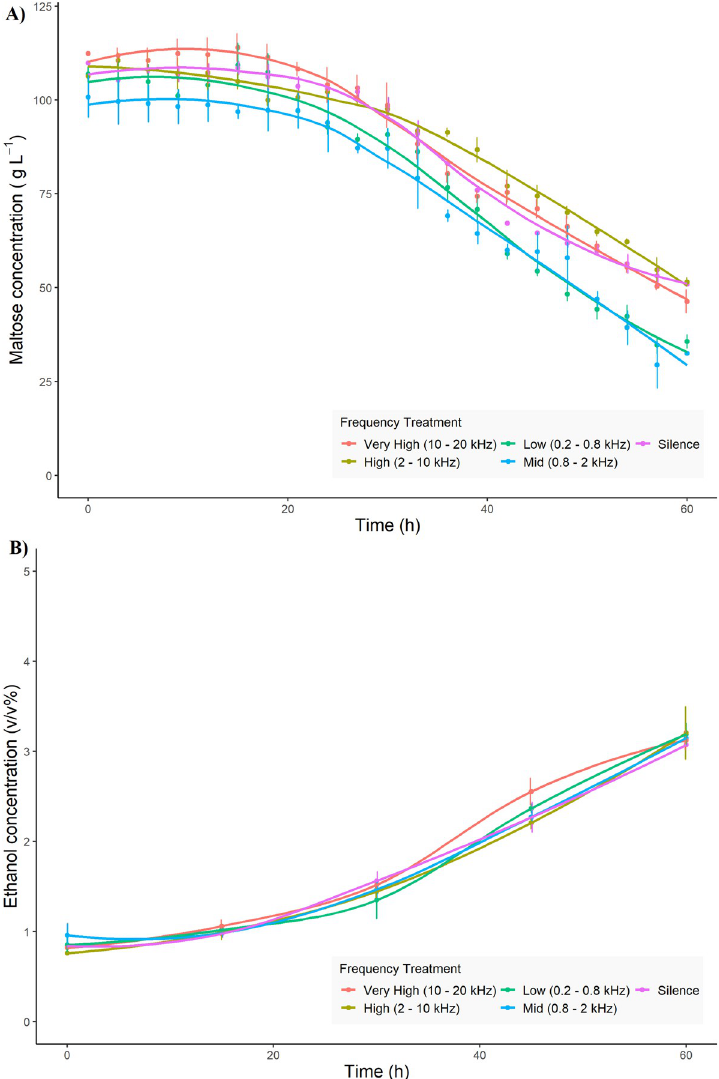
Fig 4. Characterization of S . cerevisiae US-05 fermentation parameters following exposure to different frequency sounds. A) Maltose concentration (g L -1 ) every 3 h, and B) ethanol concentration (v/v%) every 15 h, were quantified throughout the 60 h fermentation. The line of best fit is plotted for each sound treatment. Data points represent the mean of biological replicates (n = 3), with error bars showing standard deviation. See S1 Table for data used.